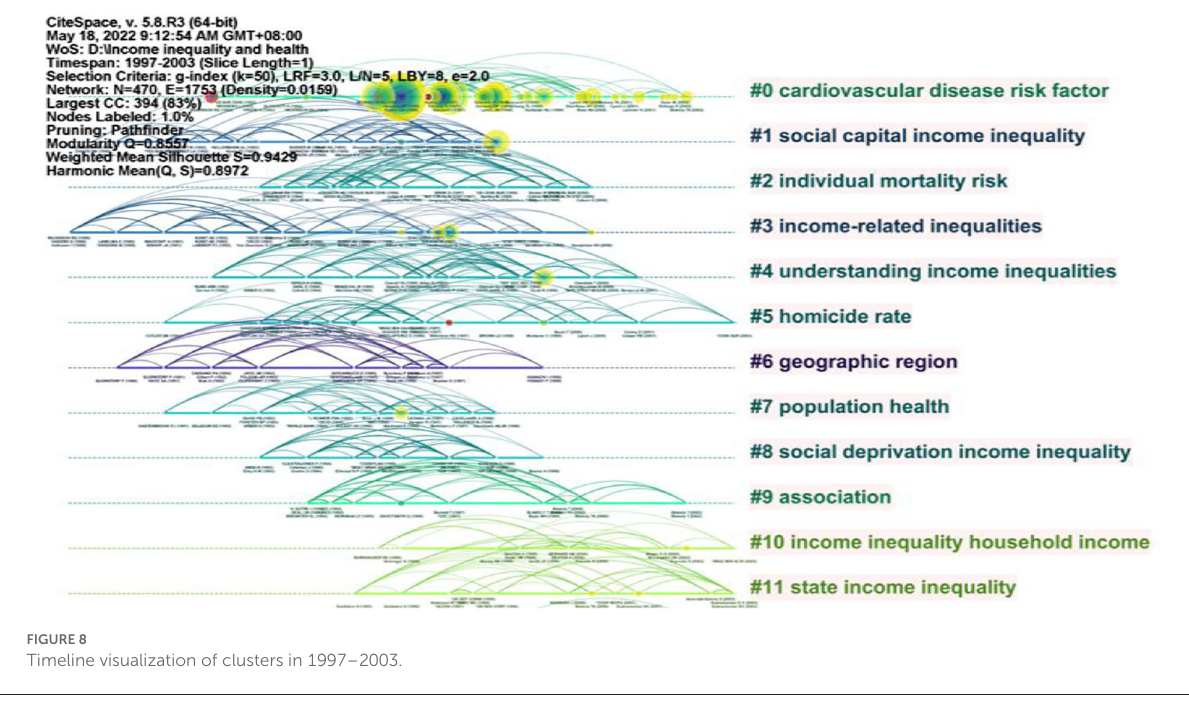
TABLE 5 References with strongest citation bursts in